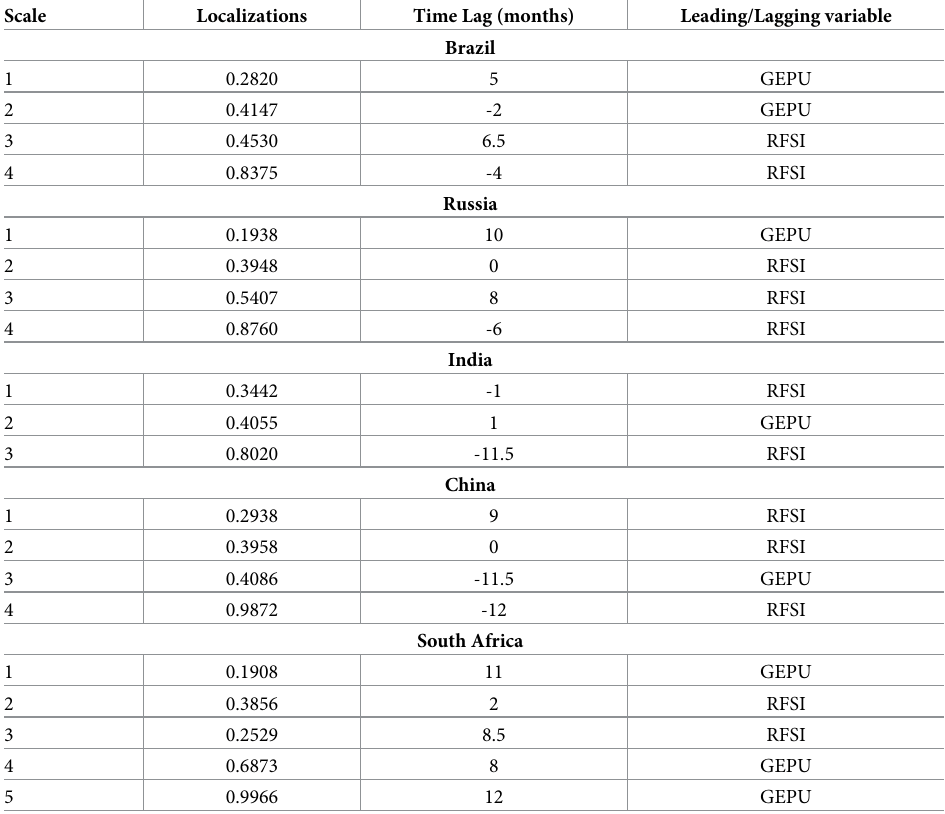
Table 6. Wavelet multiple cross correlations